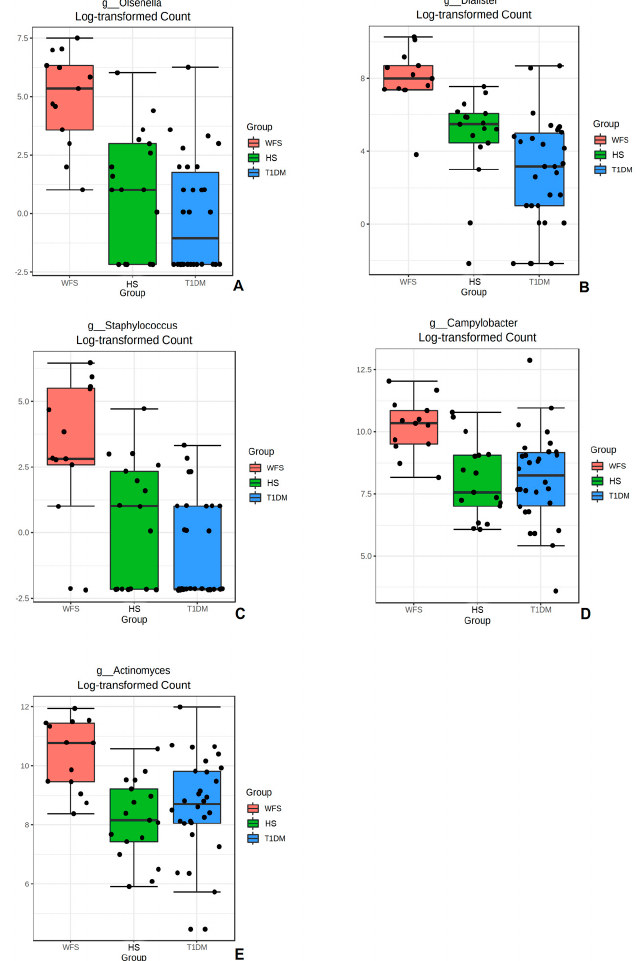
Figure 5. Boxplots comparing abundance for the groups studied for selected bacterial genera: ( A ). Olsenella; ( B ). Dialister; ( C ). Staphylococcus; ( D ). Campylobacter; and ( E ). Actinomyces. WFS—Wolfram syndrome; HS—healthy subjects; T1DM—Type 1 diabetes mellitus. Significant differences in abundance of bacteria genera among the three groups were identified using ANOVA; p < 0.001 in all presented bacteria.